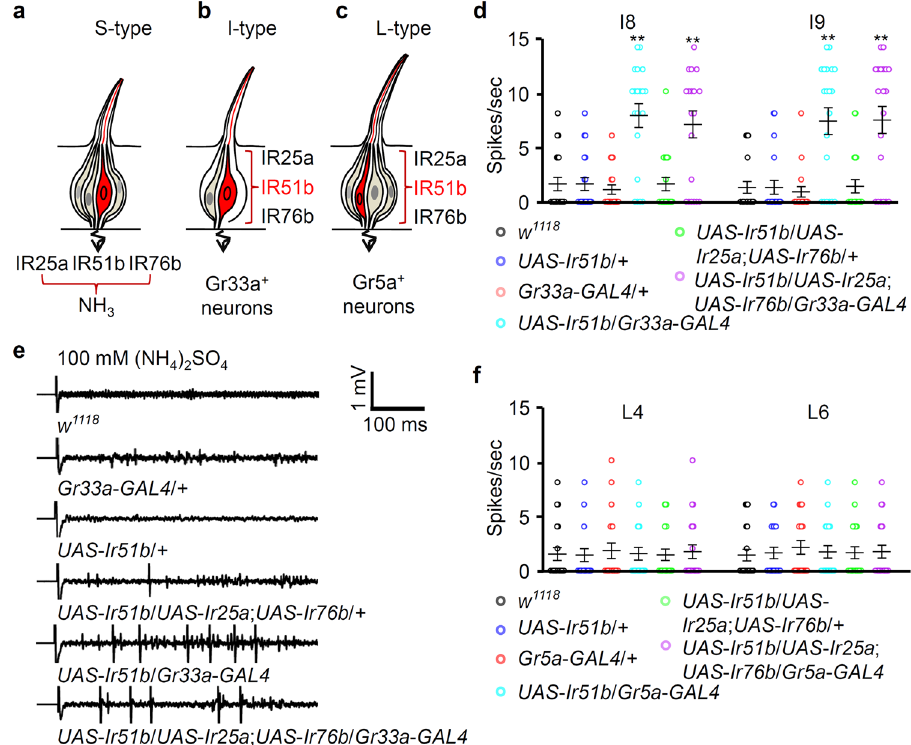
Fig. 5 Overexpression of IR25a, IR51b, and IR76b in bitter-sensing or sugar-sensing GRNs. a – c Cartoons of three different types of gustatory sensilla and their GRNs on the labellum of Drosophila. a Hetero multimeric association of Ir25a , Ir51b , and Ir76b in S-type sensilla for ammonia taste processing. b Misexpression of Ir51b cDNA in I-type sensilla. c Misexpression of Ir51b cDNA in L-type sensilla. d UAS - Ir51b alone or UAS - Ir25a , UAS - Ir51b, and UAS - Ir76b were expressed in bitter-sensing GRNs under the control of Gr33a - GAL4 . Average action potentials were generated on I8 and I9 sensilla from the labellum of the indicated genotypes with 100 mM (NH 4 ) 2 SO 4 ( n = 20). e Representative sample traces from panel ( d ). f Overexpression of Ir25a, Ir51b , and Ir76b cDNA in sugar-sensing GRNs in L-type sensilla under the control of Gr5a - GAL4 . Recordings of nerve responses were performed on L4 and L6 sensilla in the labellum of the indicated fl ies with 100 mM (NH 4 ) 2 SO 4 ( n = 20). All error bars represent SEMs. Multiple comparisons were conducted using single-factor ANOVA coupled with Scheffe ’ s post hoc test ( ** P <